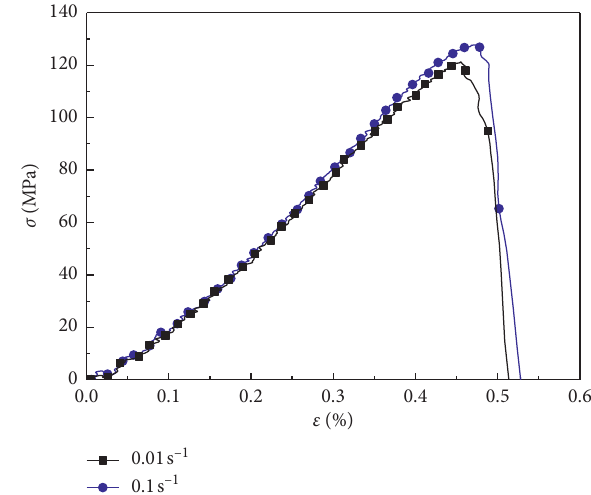
Figure 3: Stress-strain curves at different strain rates under quasi- static